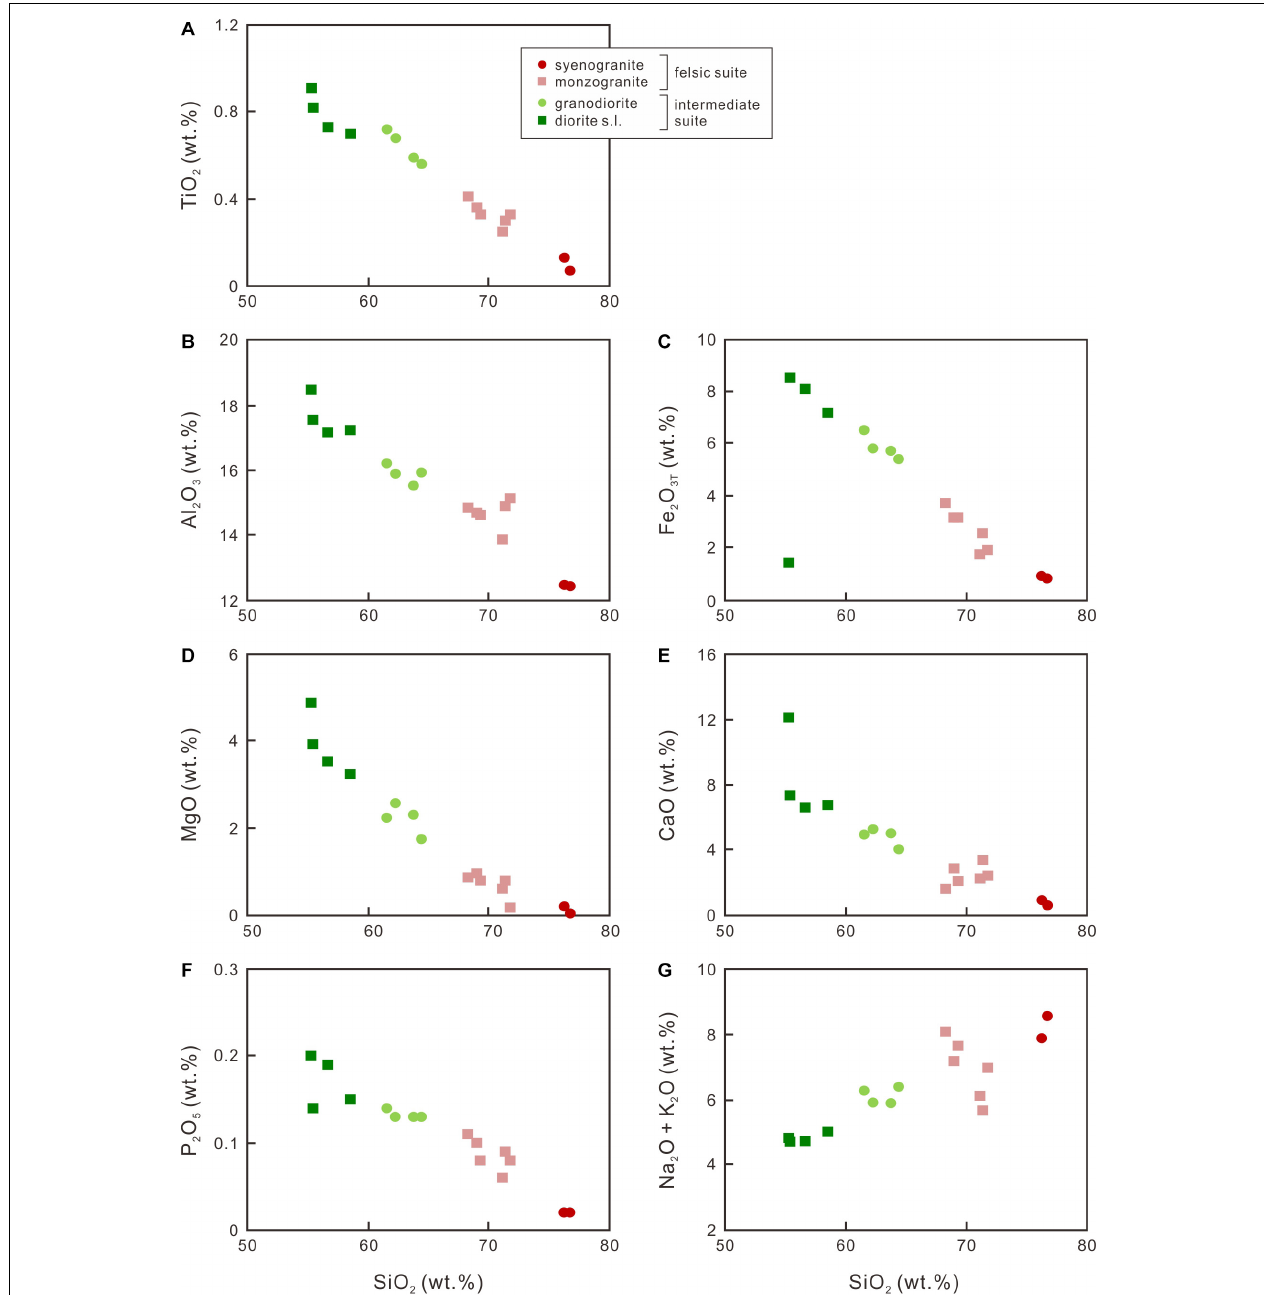
FIGURE 7 | Harker diagrams showing the variations of major element oxides against silica for the studied samples. (A) TiO 2 ; (B) Al 2 O 3 ; (C) Fe 2 O 3T ; (D) MgO; (E) CaO; (F) P 2 O 5 ; (G) Na 2 O + K 2